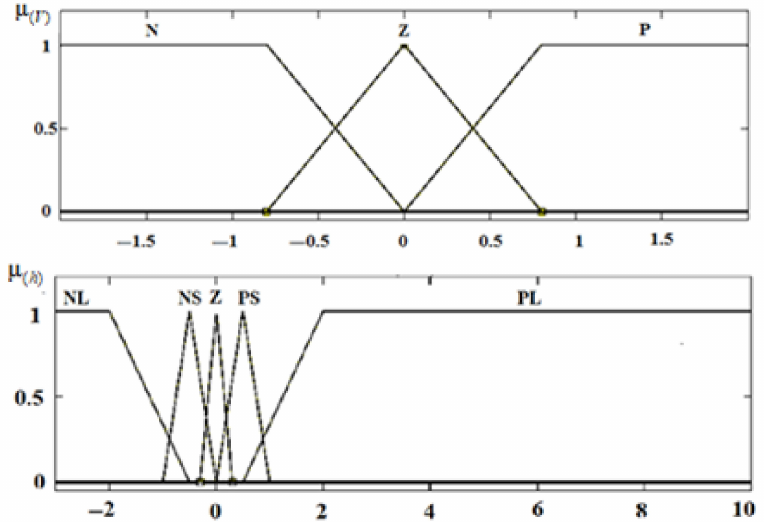
Figure 4. Functions of the terms of a fuzzy controller.